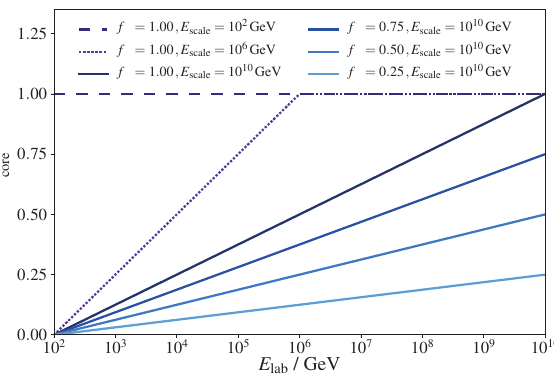
Figure 7. Di ff erent energy evolution probed for ω core . The solid lines represent changing the scale f ω of the e ff ect, while the dashed lines also indicate the e ff ect of changing E scale